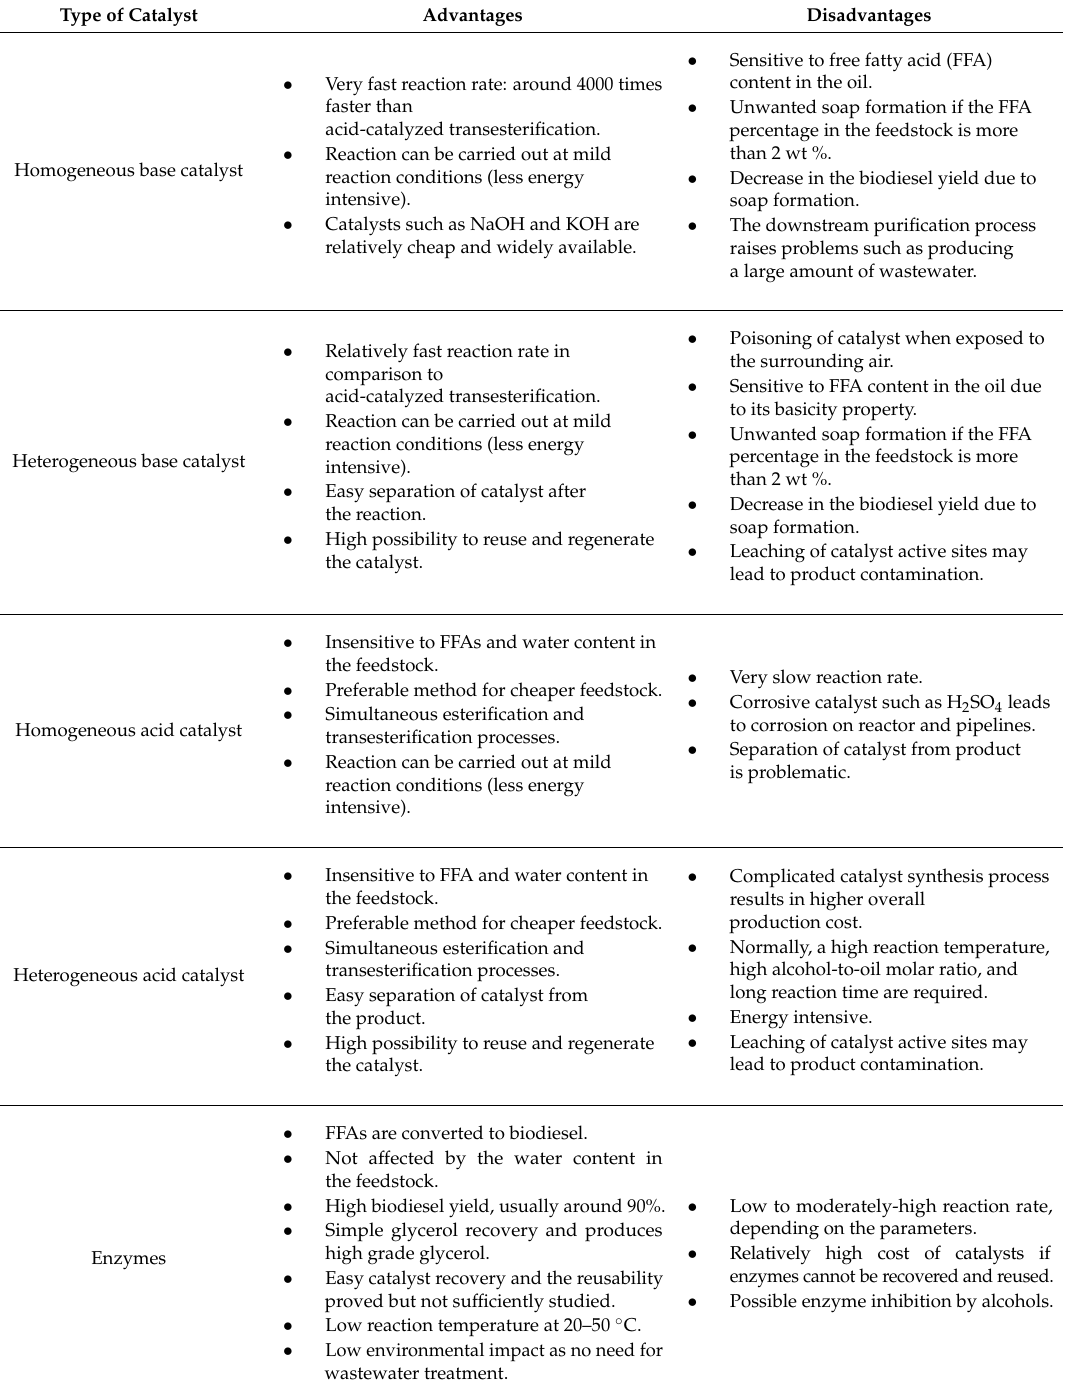
Table 3. Advantages and disadvantages of different types of catalysts in biodiesel